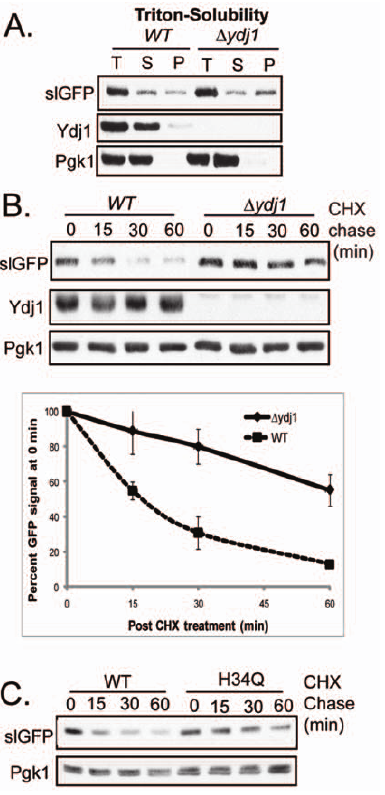
Figure 5. Loss Of Ydj1 Leads SlGFP To Accumulate In A Detergent In-Soluble State. A) Triton X-100 solubility of slGFP after high-speed centrifugation in WT or D ydj1 (T-total, S-supernatant, P- pellet). B) SlGFP turnover with quantification of slGFP turnover kinetics being shown below the gel, error bars represent 6 SEM, N=3. C) SlGFP turnover in D ydj1 expressing YDJ1 or ydj1 (H34Q) from the authentic YDJ1 promoter.